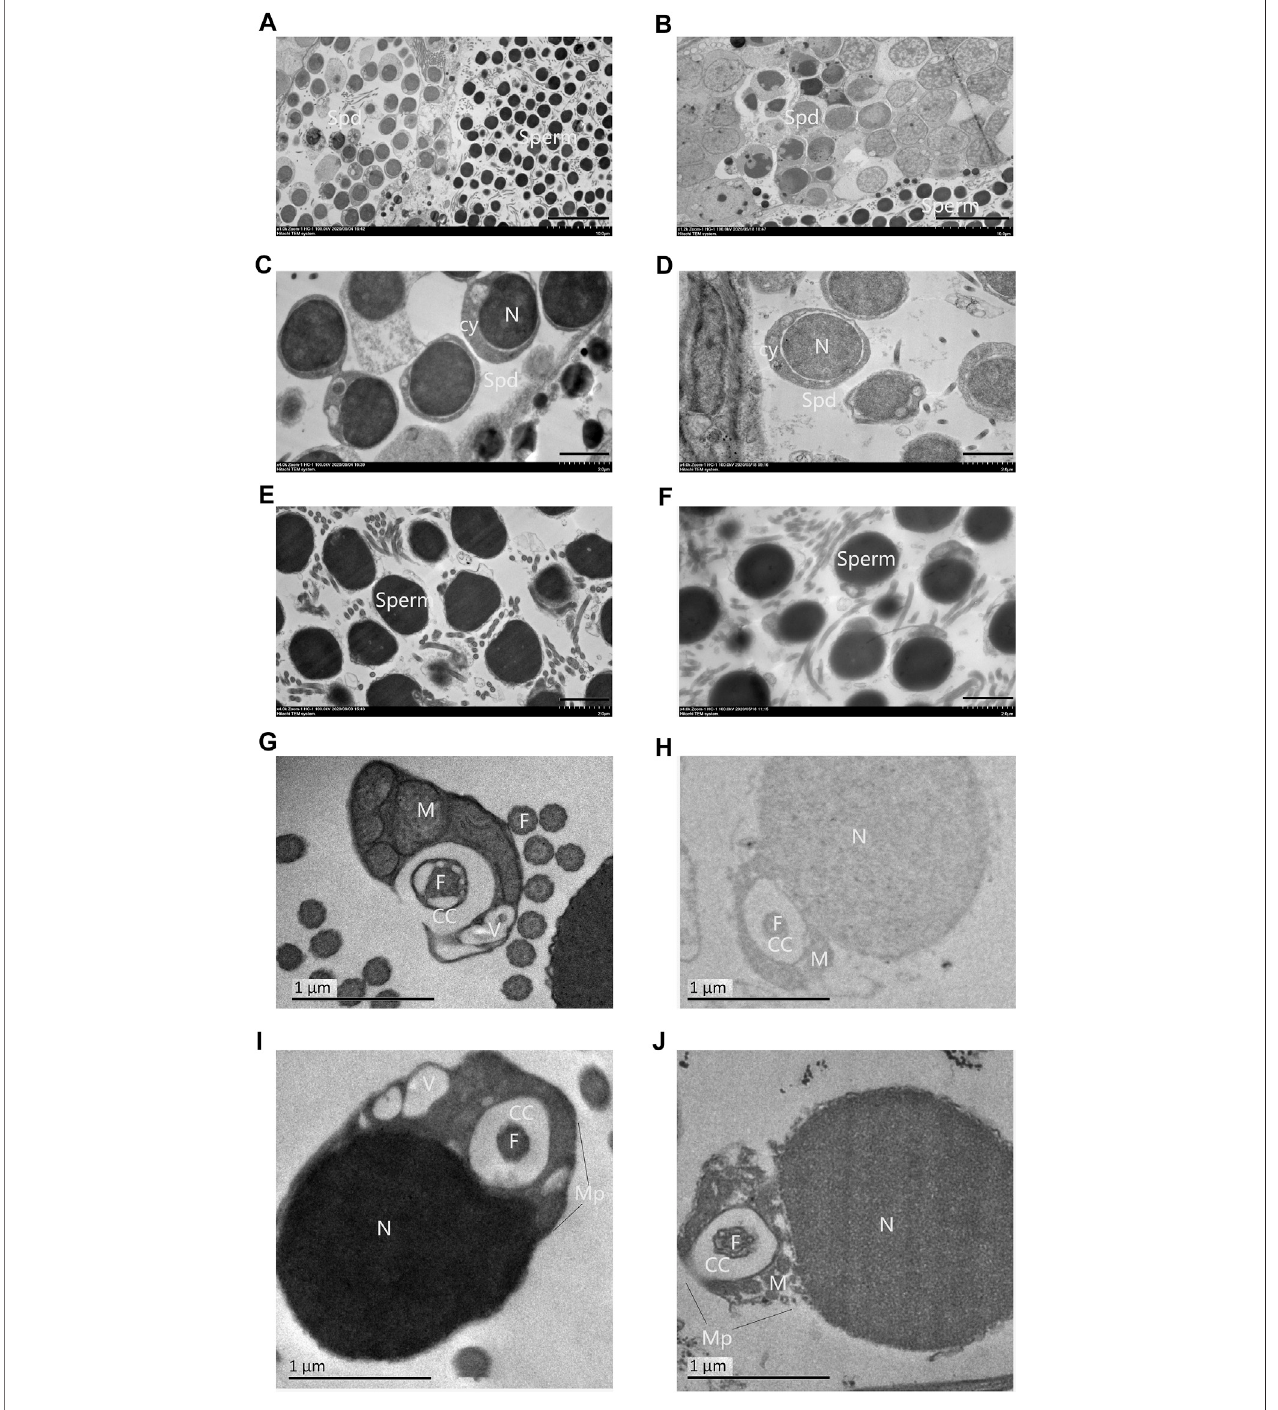
FIGURE 2 | Ultrastructures of the testes from 2nRCC and 3nDTCC. The ultrastructures of testes from 2nRCC were showed in (A) , in which spermatids were packed with higher nucleo-cytoplasmic ratios (C) , thespermatozoa heads are concentrated densely (E) ,and the midpiece organized tightly (G, I) .The ultrastructuresof testes from 3nDTCCwereshowed in (B) ,inwhich spermatids were packed withlightlystained nuclei (D) ,thespermatozoa heads areconcentrateddensely (F) ,and the midpiece organized loosely (H,J) . Spd, spermatid; Cy, cytoplasm; N, nucleus; V, vesicle; Cc, cytoplasmaticchannel; F, fl agellum (centriole);Mp, midpiece; and M, mitochondria. Bar in A, B is 10 μ m; Bar in C-F is 2 μ m; Bar in G-J is 1 µm.